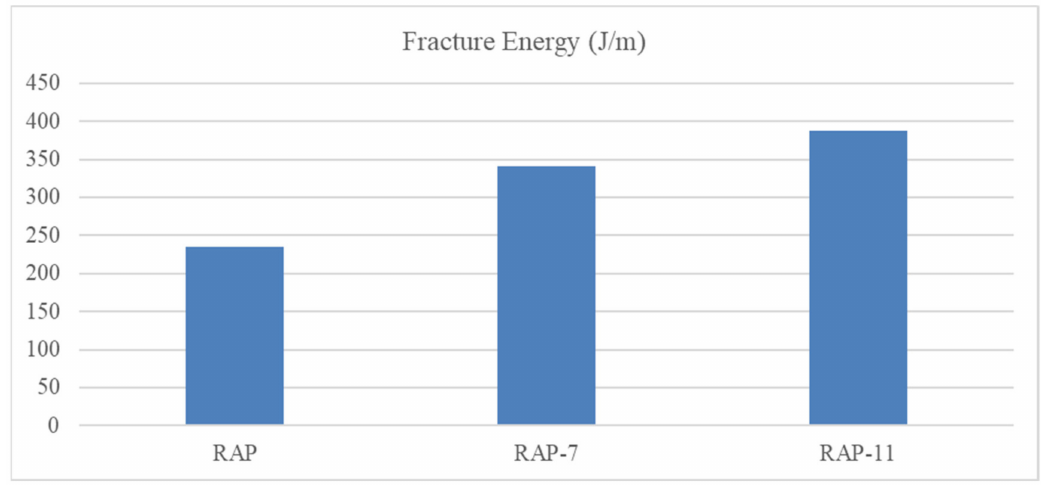
Figure 9. Average fracture energy of